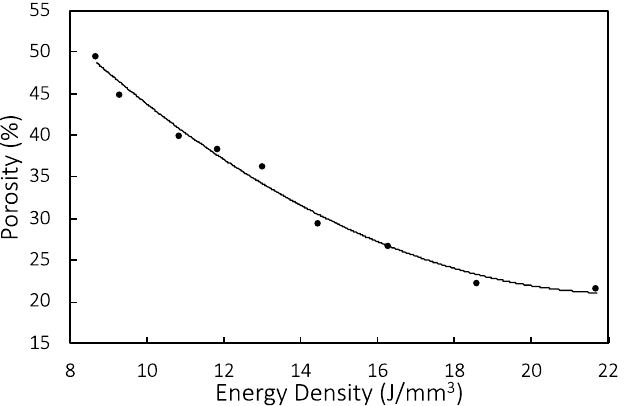
Figure 14. Relationship between experimental energy density and porosity shown with regression equation.